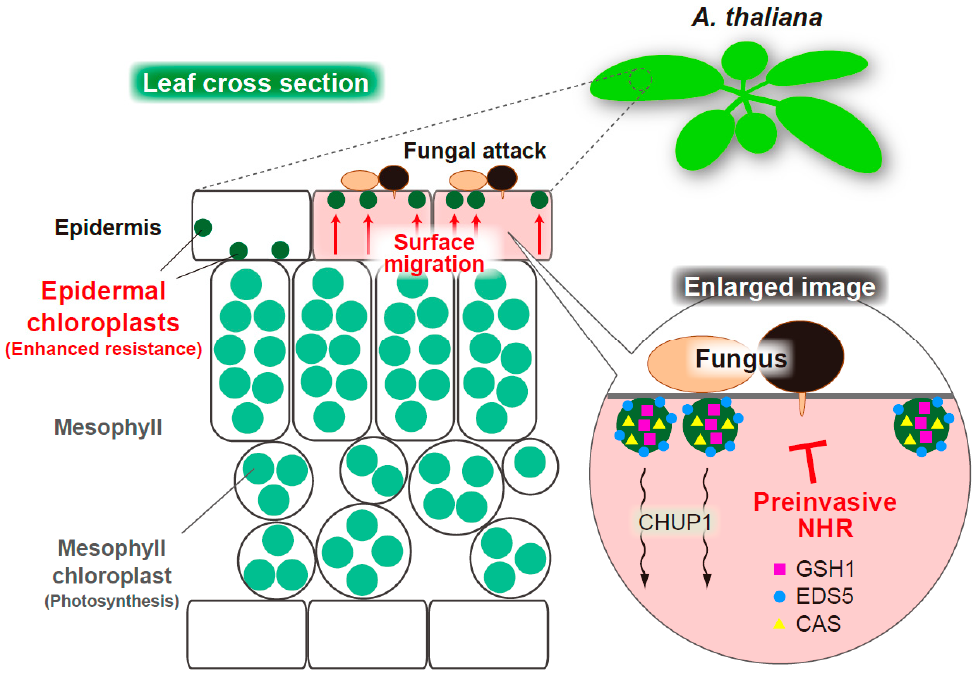
Figure 4. Schematic overview of the ECR-mediated preinvasive NHR in epidermis of A. thaliana . An MAE trial of nonadapted fungi triggers the CHUP1-related ECR. The epidermal chloroplast-localized immune components GSH1, EDS5, and CAS alter their intracellular locations on activation of ECR. The ECR and these immune components contribute to epidermal preinvasive NHR against fungal pathogens.